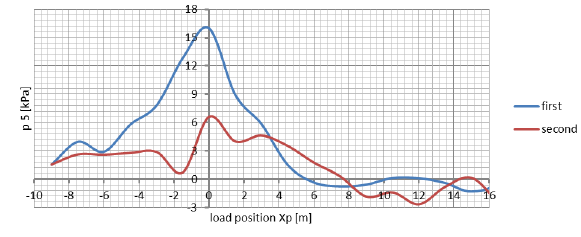
Figure 10: Normal interactions during loader travel over soil-steel structure in Rydzyna.